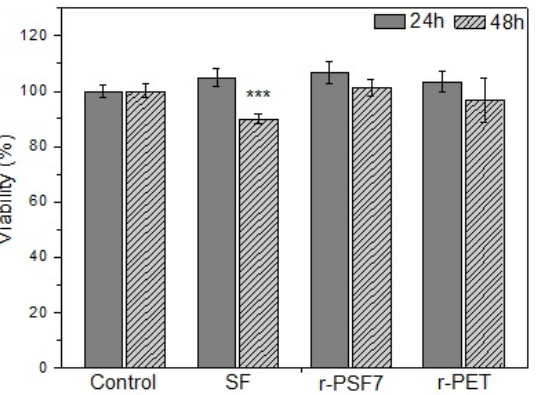
Figure 10. Biocompatibility of SF, r-PSF6, and r-PET mats after 24 h and 48 h incubation, respectively. Cell viability was determined by MTT assay. The results are presented as mean ± SD of three independent experiments. The statistical significance is shown by asterisks (*** p < 0.001).